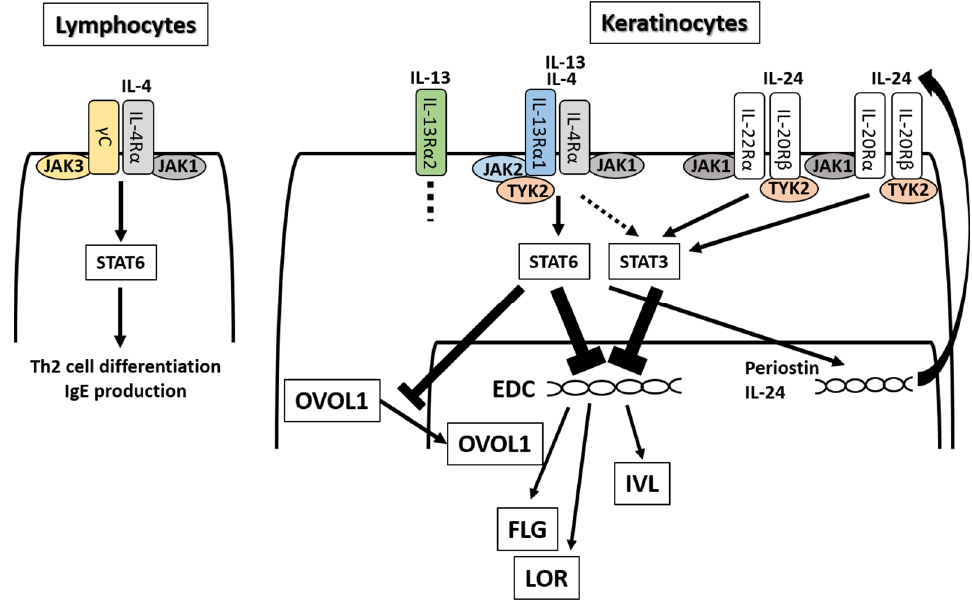
Figure 3. IL-4 and IL-13 have partly shared receptor systems. IL-4 binds IL-4Rα/γC in lymphocytes and other hematopoietic cells, activates the JAK1/JAK3-STAT6 pathway, and induces Th2 differentiation and IgE production. IL-4 and IL-13 share IL-4Rα/IL-13Rα1 in keratinocytes, activate the JAK1/JAK2/TYK2-STAT6 and -STAT3 pathway, and inhibit the expression of EDC molecules such as FLG, LOR, and IVL. IL-4 and IL-13 also inhibit the cytoplasmic-to-nuclear translocation of OVOL1 and downregulate the expression of FLG and LOR. IL-4/IL-13-mediated STAT6 activation